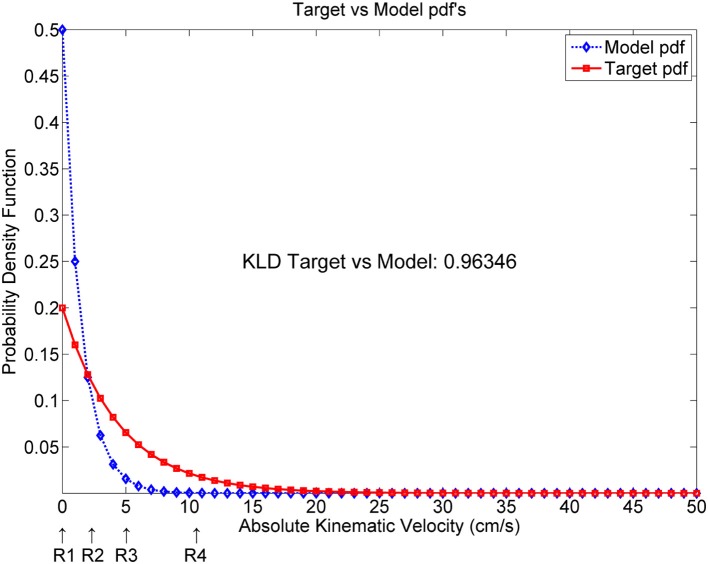
Simulated AKV probability density functions from a target (pathologic speaker) and a model (normative speaker). KLD: Kullback-Leibler Divergence.